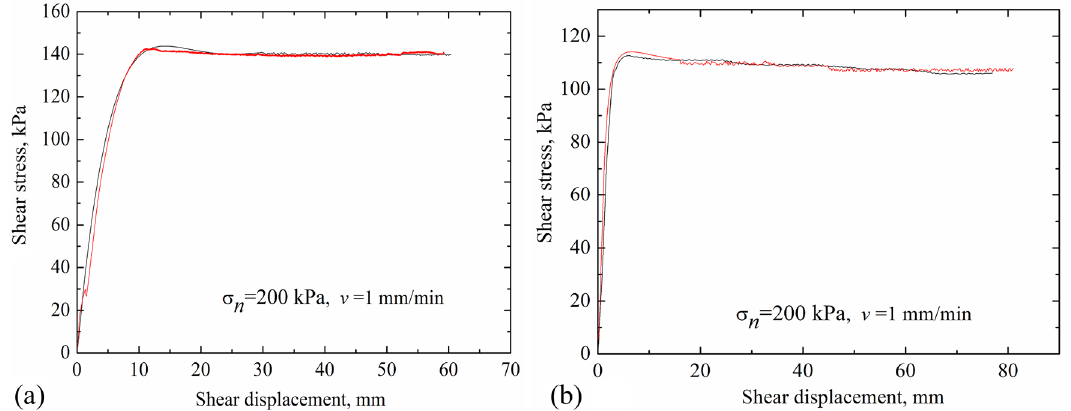
Figure 5. Verification of stability of the ring shear test. ( a ) Saturated loess; ( b ) saturated red clay.